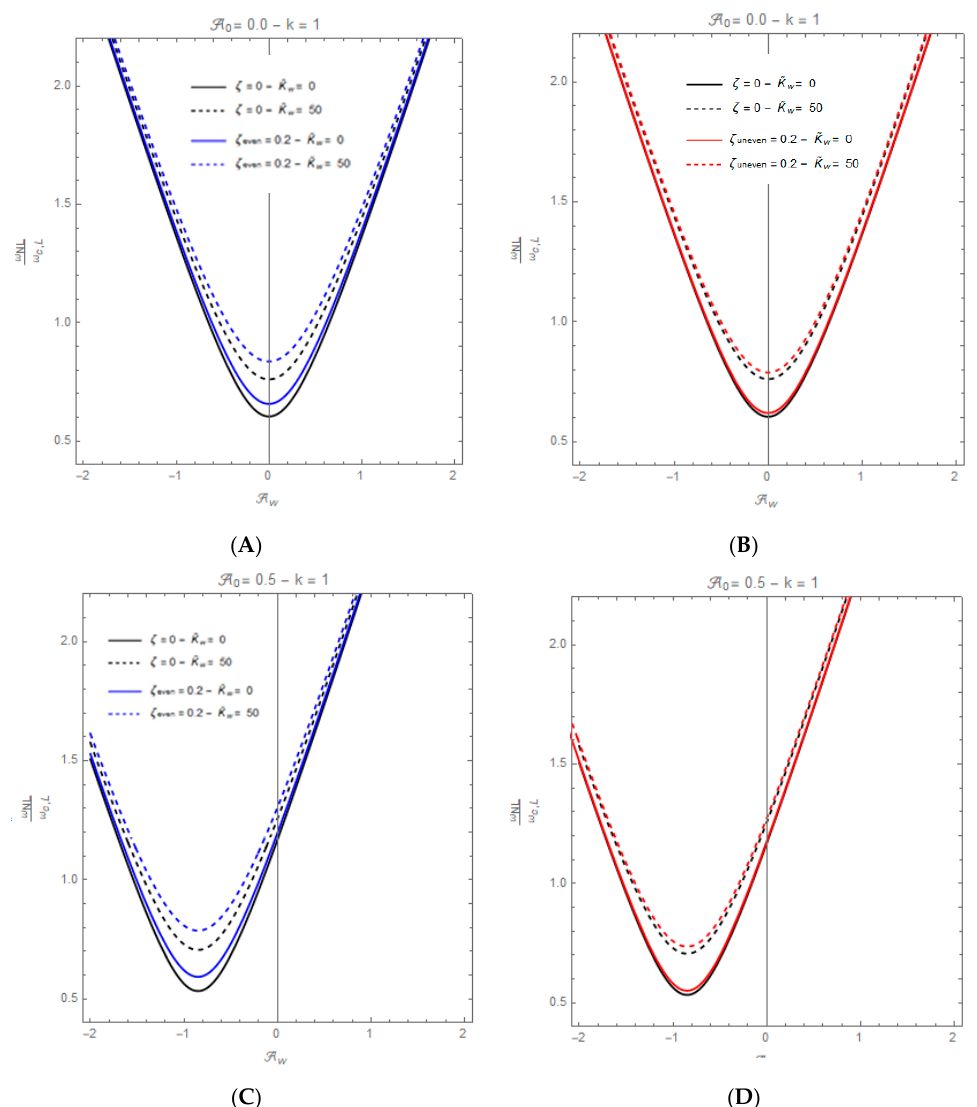
Figure 10. E ff ect of porosity volume fraction ( ζ ) and Winkler elastic foundation coe ffi cient ( K w ) on the frequency ratio of simply-supported (SS) porous perfect ( A 0 = 0.0) FG nano-beams: ( A ) even distribution of porosity (blue lines), ( B ) uneven distribution of porosity (red lines). E ff ect of the porosity volume fraction ( ζ ) and the Winkler elastic foundation coe ffi cient ( K w ) on the frequency ratio of simply-supported (SS) porous imperfect ( A 0 = 0.5) FG nano-beams: ( C ) even distribution of porosity (blue lines), and ( D ) uneven distribution of porosity (red lines).